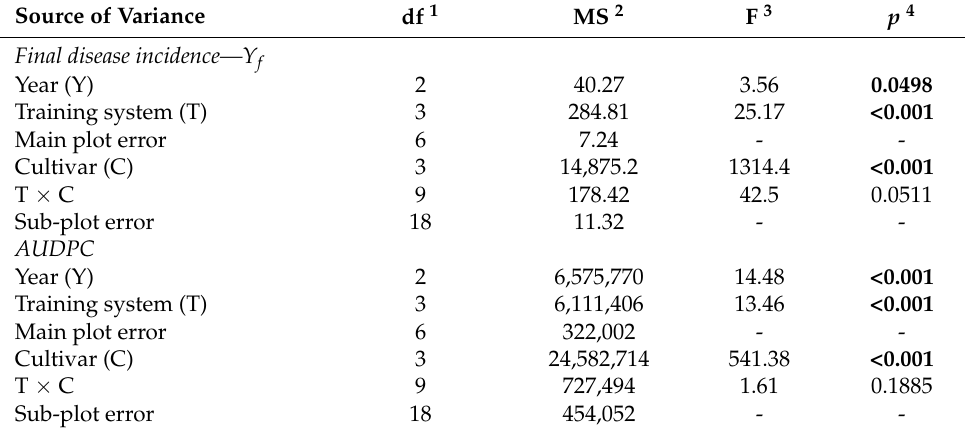
Table 4. Analyses of variance for the effects of years (2017, 2018 and 2019); training systems (4 × 1.5, 4 × 2, 5 × 2.5 and 6 × 3 m); and cultivars (‘ ˇCaˇcanska lepotica’, ‘Bluefre’, ‘Stanley’ and ‘President’) on final disease incidence ( Y f ) and Area Under the Disease Progress Curve (AUDPC) of shot hole disease in an integrated plum orchard at Debrecen-Pallag, East Hungary. Bold figures indicate significant differences at p < 0.05.